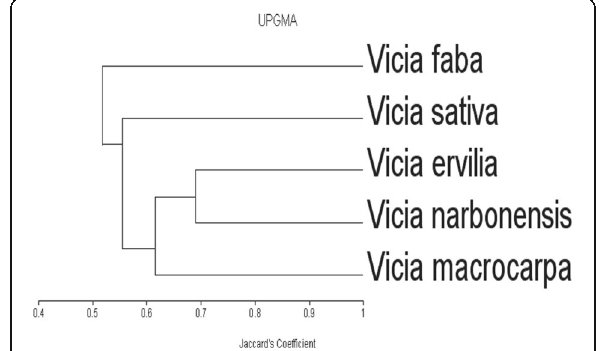
Fig. 5 UPGMA dendrogram of Vicia species based on frequencies of collective date of seed soluble proteins and non-soluble